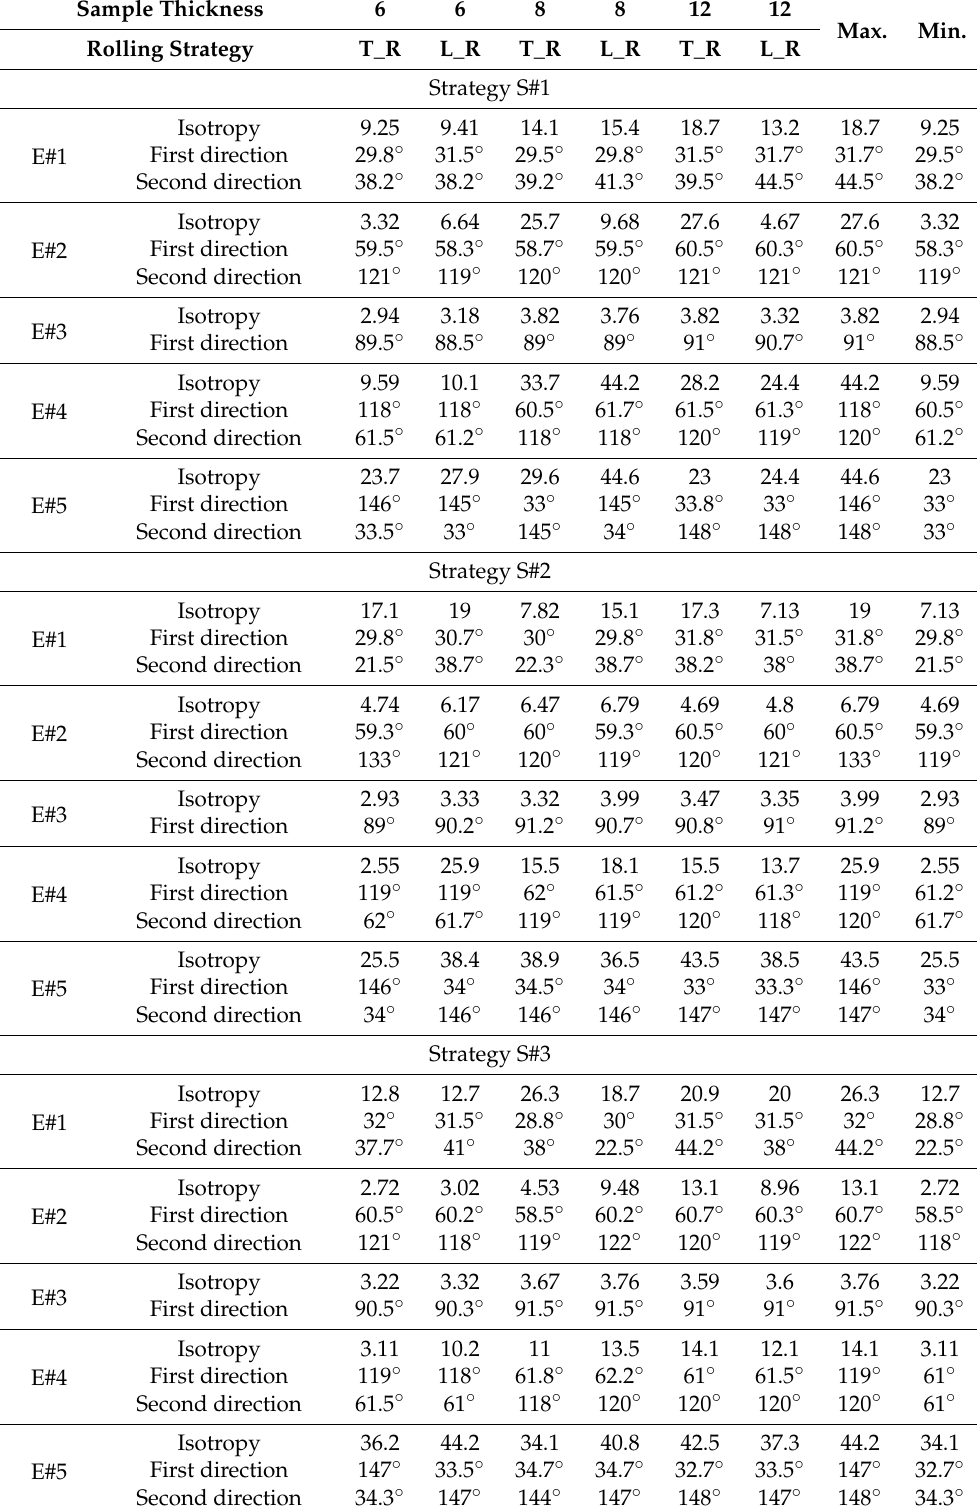
Table 5. Isotropy and directional properties of surface